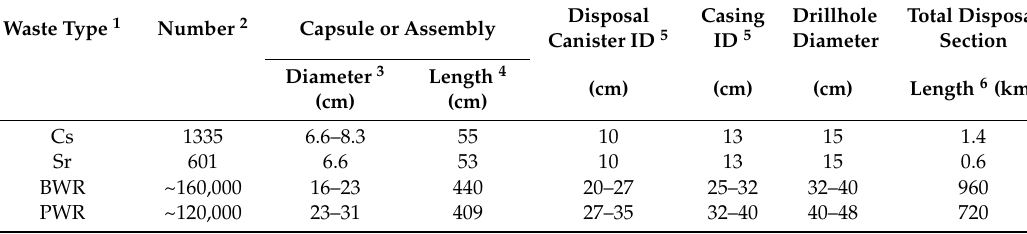
Table 1. Geometry of waste and required drillhole dimensions, based on References